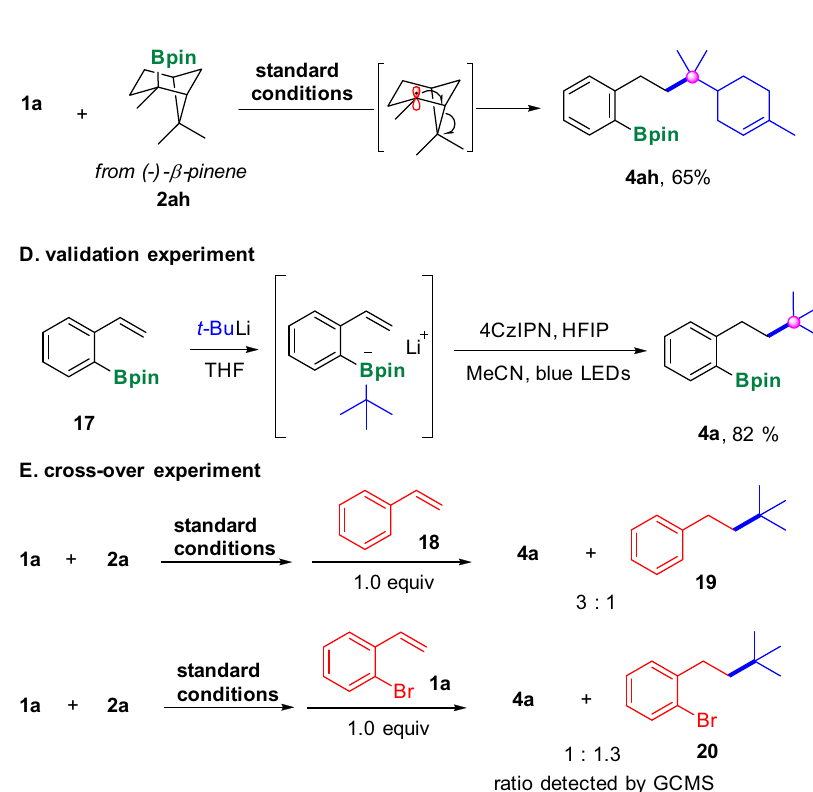
Fig. 6 Control experiments. A Radical capture experiment; ( B ) Deuteration experiment; ( C ) Radical-clock experiment; ( D ) Validation experiment; ( E ) Cross-over